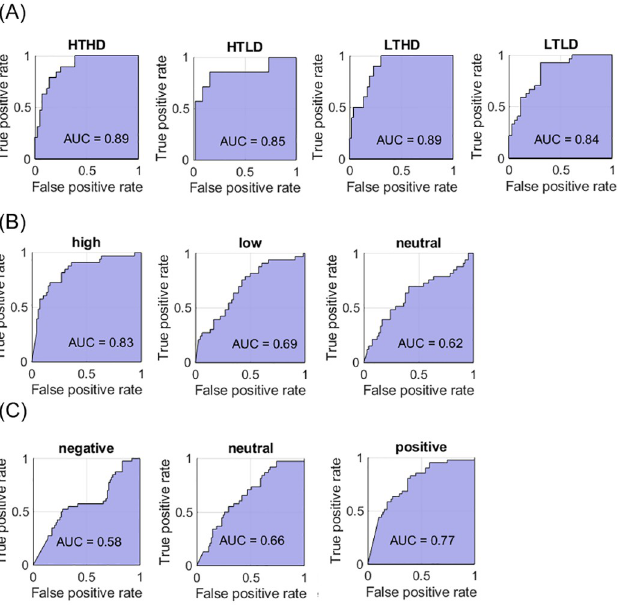
Fig 2. Receiver Operating Characteristic (ROC) curves for bi-dimensional profiles (A), valence (B) and dominance (C) classification for Polynomial